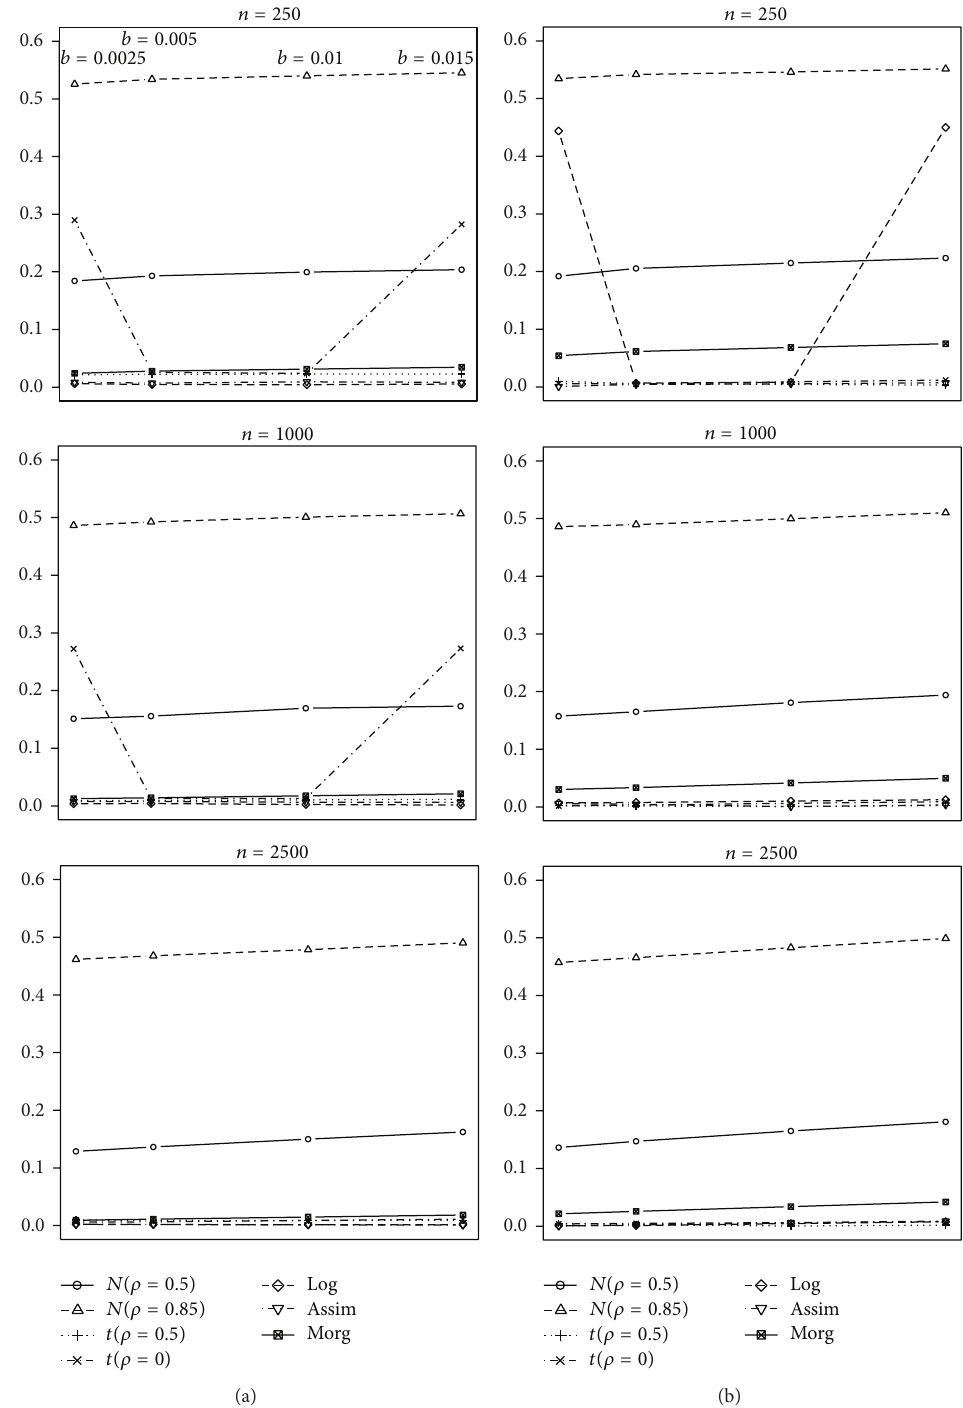
̂𝜆 LOG ̂𝜆 SEC (a) and estimator (b). The four values plotted in each line correspond to 𝑏 =